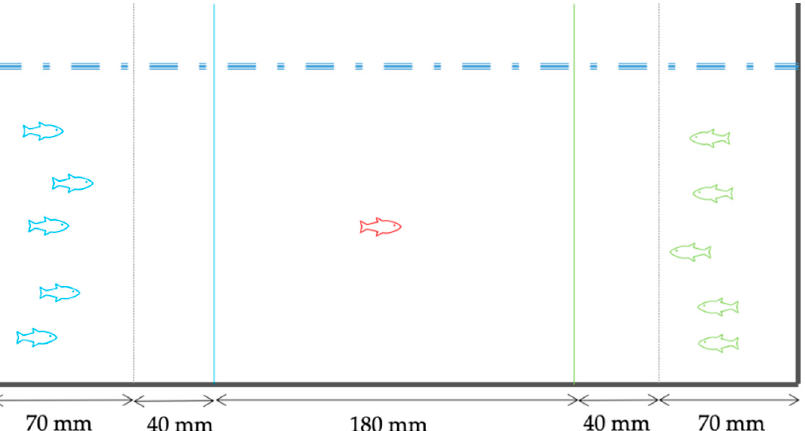
Figure 1. Scheme of the test tank (not drawn to scale). The focal fish is allowed to explore the cen ‐ tral compartment and interact with the stimulus shoals placed at the two end compartments (70 mm). Focal and stimulus fish are separated by Plexiglas barriers (perforated and opaque, non ‐ perforated and transparent and perforated and transparent for chemical, visual, and chemical and visual simultaneous tests, respectively). The two preference zones for each of the shoals are also marked (40